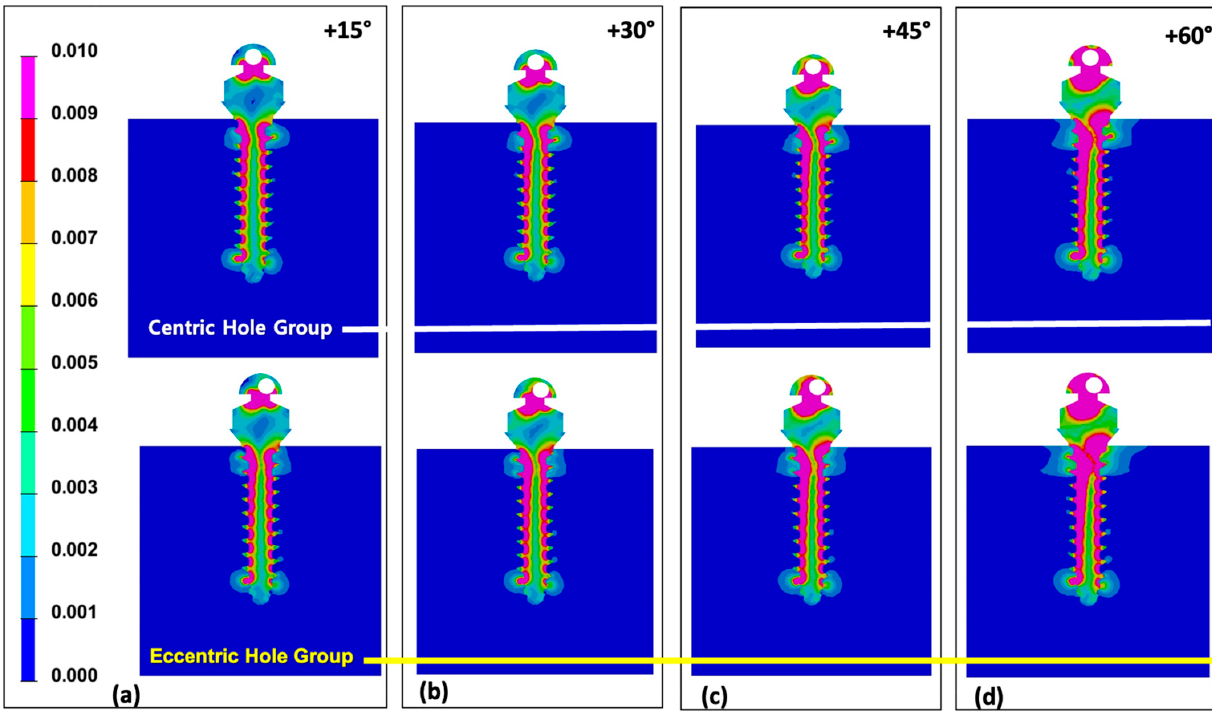
Figure 4. Distribution of Von-Mises stress under the condition of 1 ° counter-clockwise rotation of the miniscrew: ( a ) centric hole group; ( b ) eccentric hole group. Both groups showed relatively even distribution of Von-Mises stress.